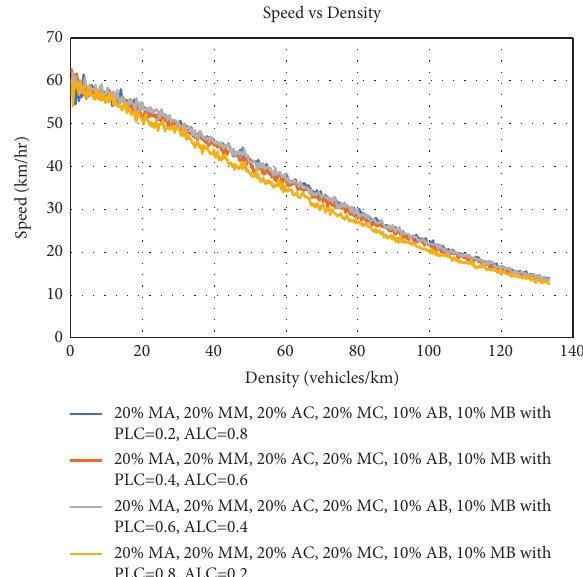
Figure 9: Speed vs. density fundamental diagrams for different compositions of MA, MM, AC, MC, AB, and MB with different values of ALC and PLC.